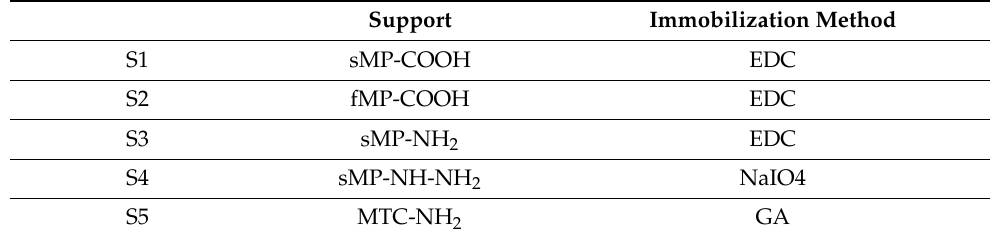
Table 3. Immobilized lipase